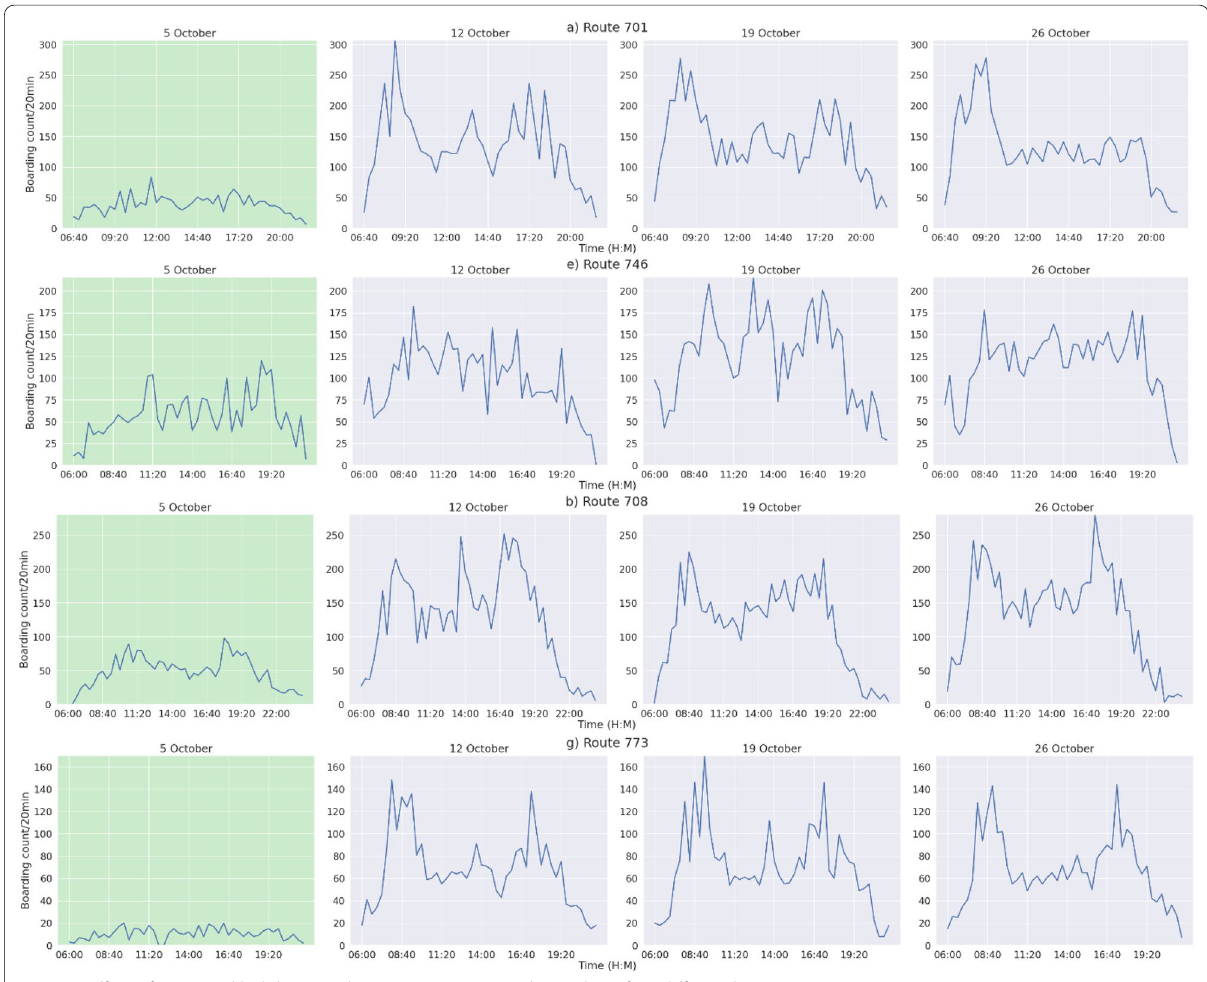
Fig. 15 Effect of a national holiday (October 5) on passenger volume along four different bus